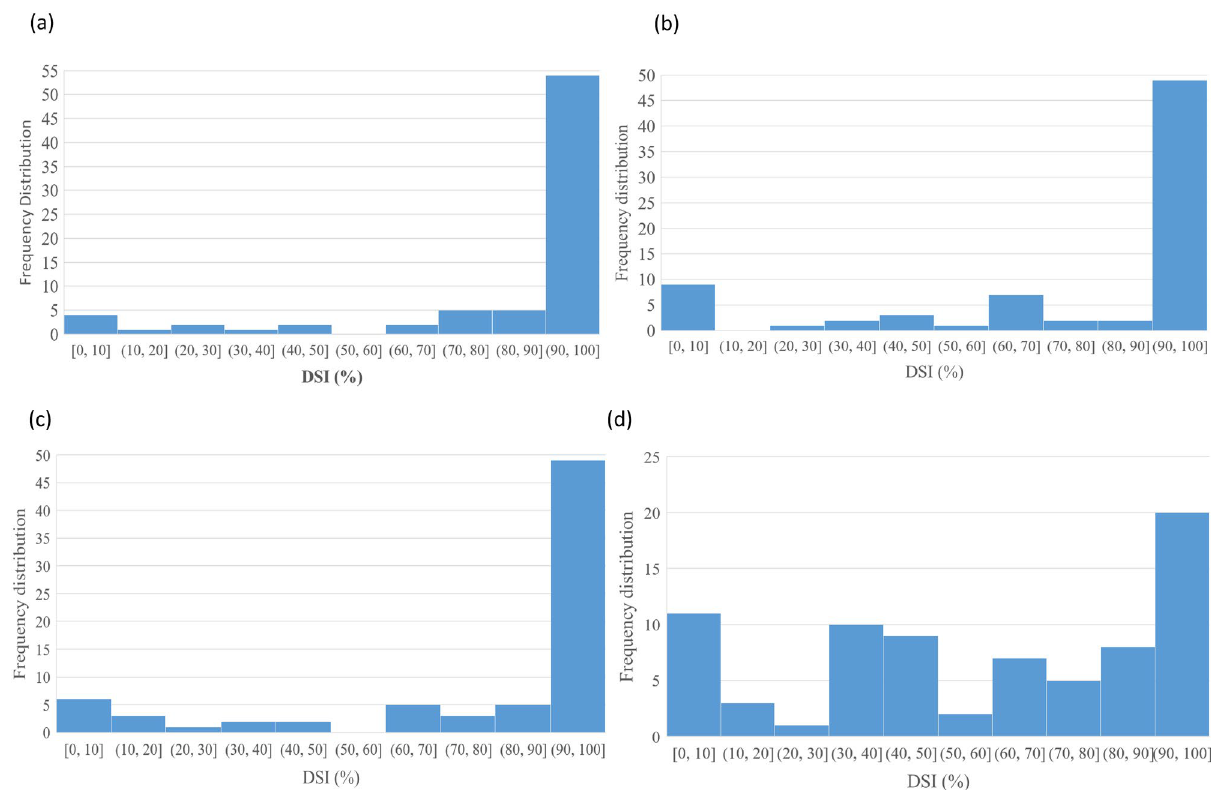
Figure 1. Frequency distribution of accessions of Brassica napus plotted against clubroot severity (disease severity index, DSI) for pathotypes ( a ) 5X, ( b ) 2B, ( c ) 3A, and ( d )